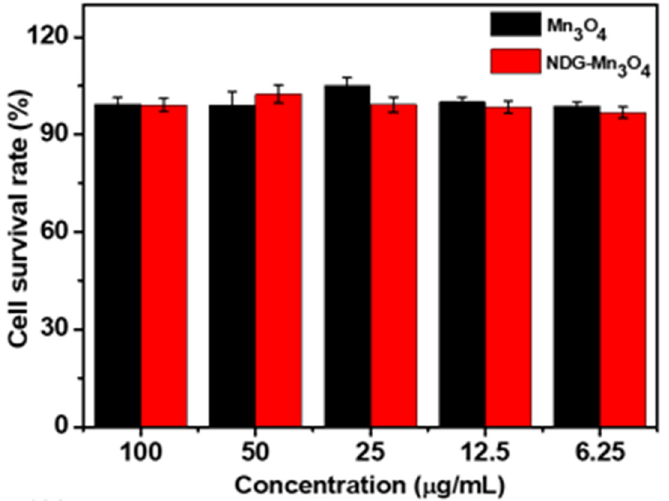
Figure 4. Cytotoxicity analysis showing cell viability of A549 cells treated with different concentrations of Mn 3 O 4 and NDG-Mn 3 O 4 nanocomposites. Values are means of three replicates ± standard error.